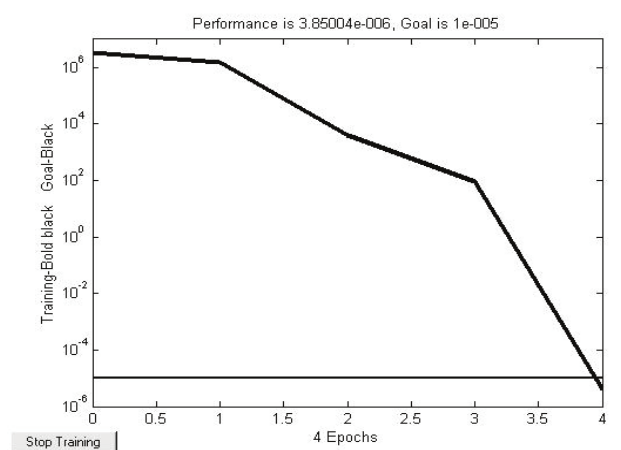
Fig. 12. Tradeoff Points and Convex hull of the final gener- ation population : First case study